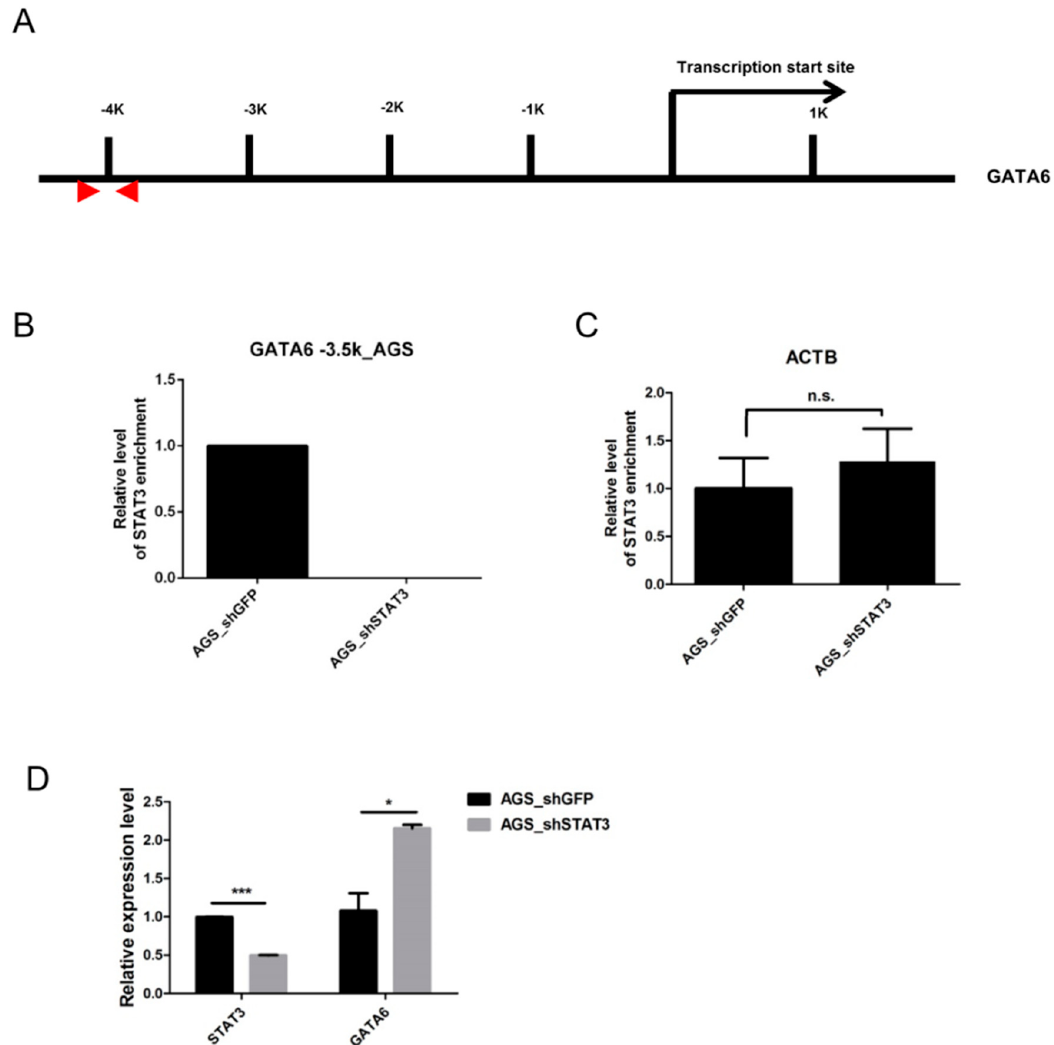
Figure 3. Binding of STAT3 represses GATA6 expression in AGS gastric cancer cells: Using lentiviral small hairpin RNA (shRNA), chromatin immunoprecipitation (ChIP)-PCR experiments were performed to examine the relative binding of STAT3 to the GATA6 promoter in AGS cells and cells with depleted STAT3. ( A ) The genomic structure of the GATA6 promoter and the location of the ChIP-PCR primer (red arrow heads) targeting the putative STAT3 binding site at the upstream promoter region. STAT3 binding was significantly enriched in the ( B ) GATA6 promoter but not ( C ) β -actin ( ACTB ) promoter (negative control) in AGS cells; ( D ) Depletion of STAT3 significantly restored GATA6 expression in AGS cells. *** p < 0.005, * p < 0.05. n.s.: not significant.